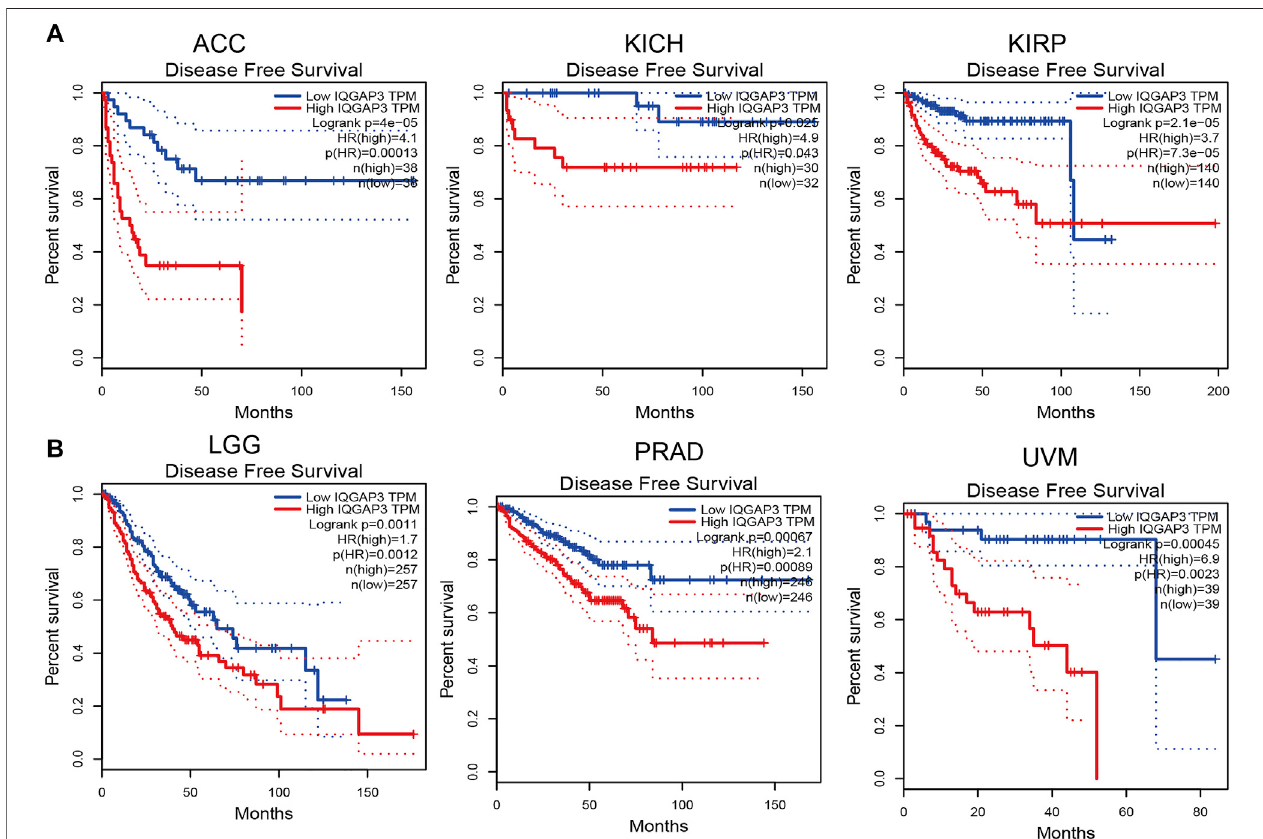
FIGURE 4 | Analysis of the disease-free survival for IQGAP3 in human cancers. (A) The disease-free survival for IQGAP3 in adrenocortical carcinoma, kidney chromophobe,andkidneyrenalpapillarycellcarcinomaanalysisbyusingtheGEPIAdatabase,and (B) thedisease-freesurvivalforIQGAP3inbrainlowergradeglioma, prostate adenocarcinoma, and uveal melanoma analysis by using the GEPIA database.